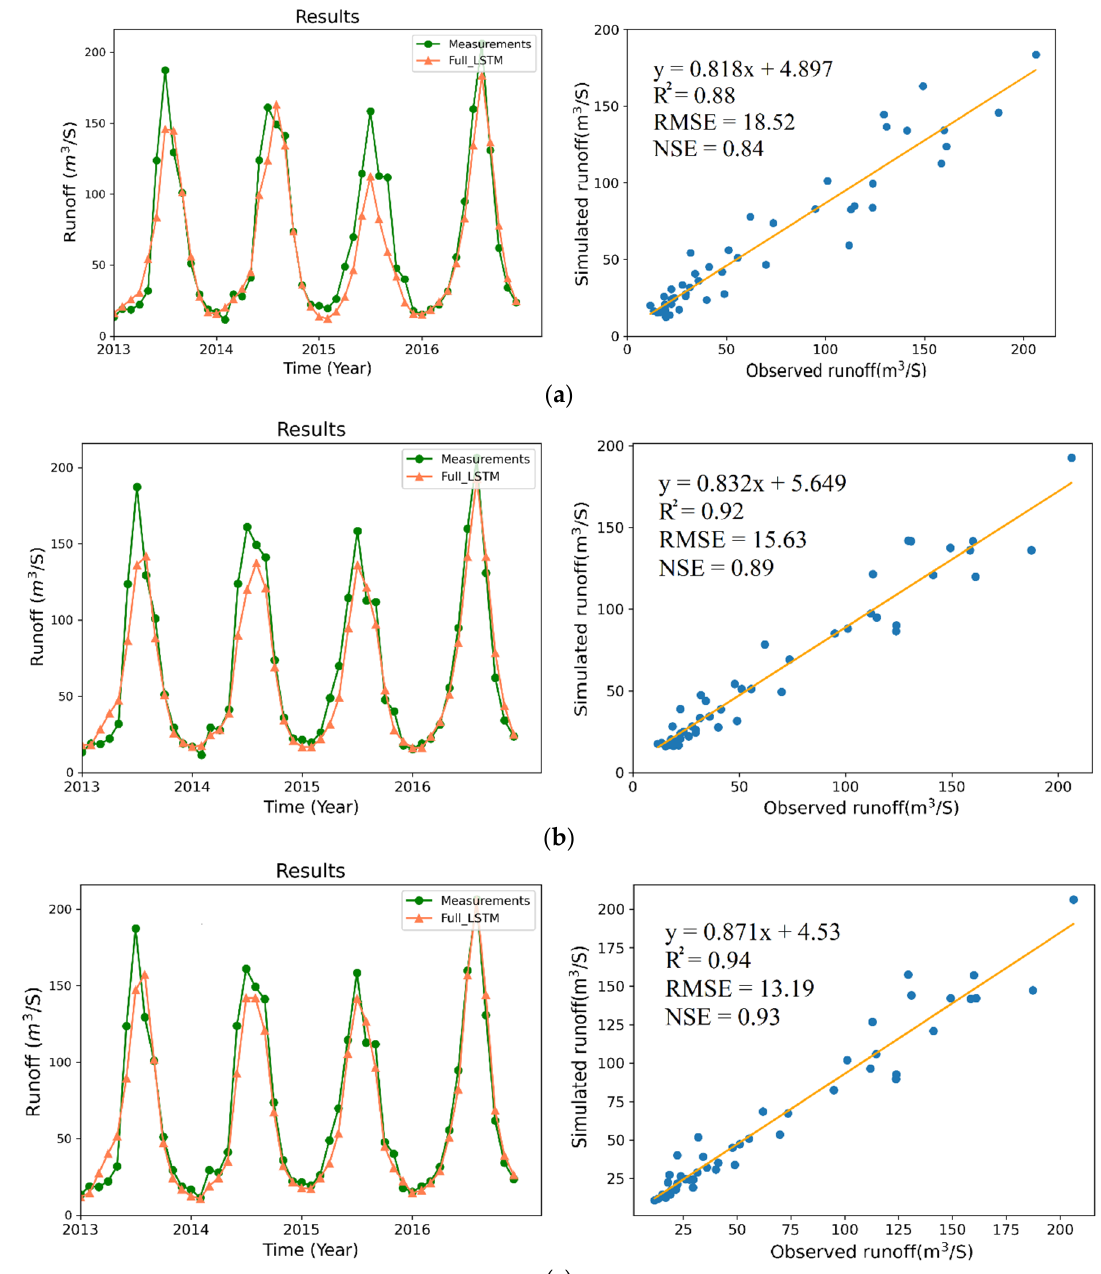
Figure 10. ( a ) Performances of the model under L3 input; ( b ) performances of the model under L4 input; ( c ) performances of the model under L5 input. In the left half, the green and orange broken lines represent the observed runoff and estimated runoff, respectively. On the right side, the orange line indicates the linear regression trendline for the observed runoff and simulated runoff.